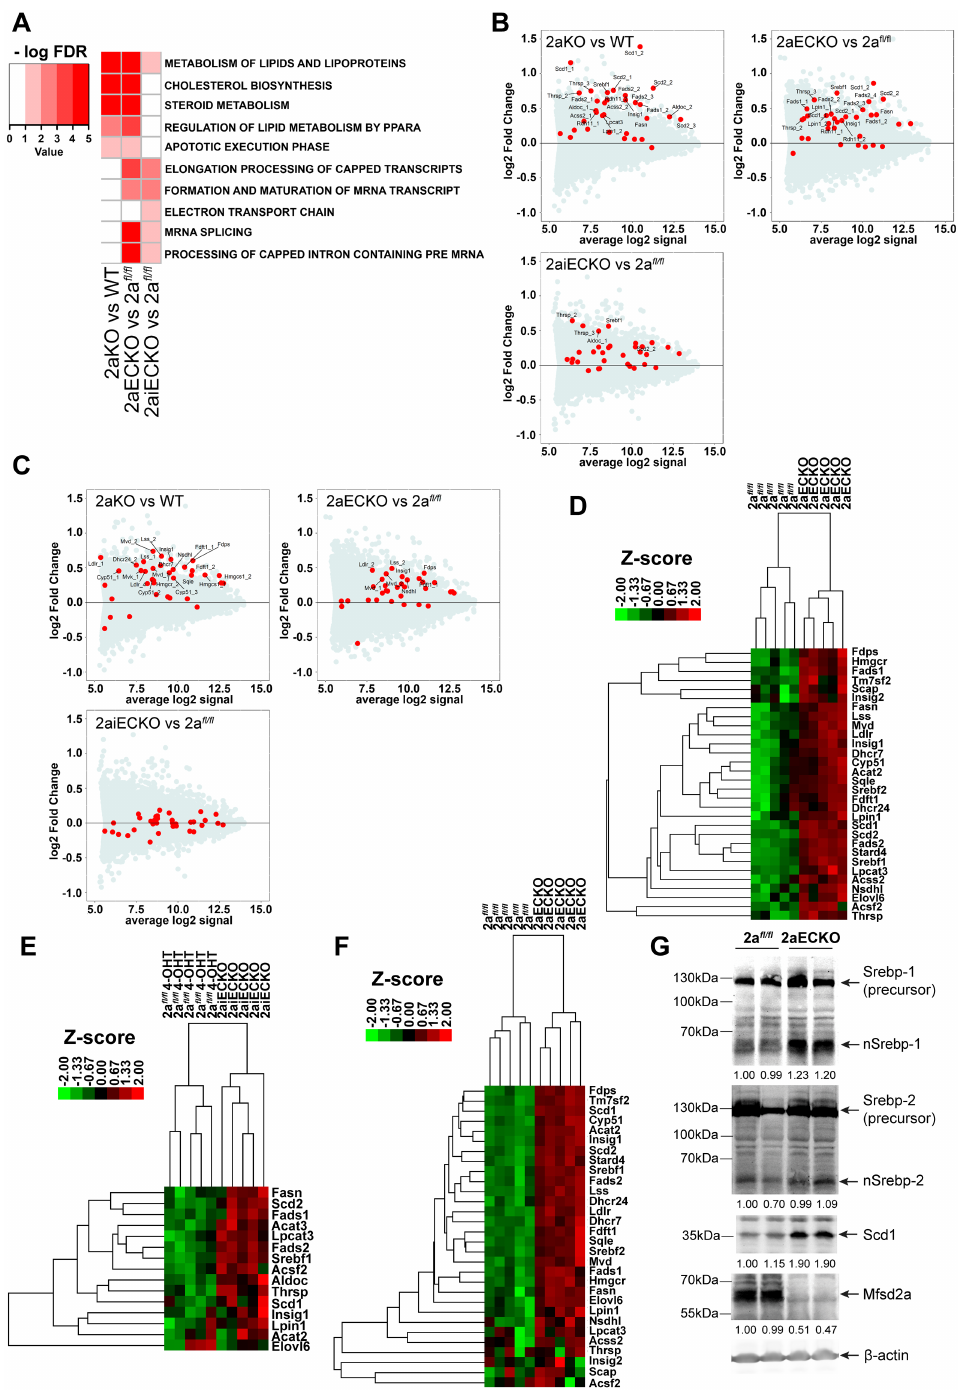
Fig 3. De novo lipogenesis pathways are up-regulated in DHA-deficient brains. (A) Gene microarray analysis of brains from P8 mice. Heatmap represents commonly up-regulated Reactome pathways with an FDR (cid:20) 5%. Only pathways that are commonly up-regulated in at least 2 genotype comparisons (2aKO versus WT or 2a fl/fl versus 2aECKO/2aiECKO) are shown. RNA was pooled from 5–6 cerebrums according to their genotype. Color key indicates negative logarithm of the FDR for the selected pathways, for which a higher value indicates the pathway is more significantly different. (B) Increased Srebp-1 pathway genes in Mfsd2a deficiency mouse models. Data are represented as MA plots of gene microarray analysis of brains from P8 mice. MA plot is used to visualize intensity-dependent ratio of raw gene microarray data and indicated that the top-ranked pathway that was up-regulated in 2aKO, 2aECKO,